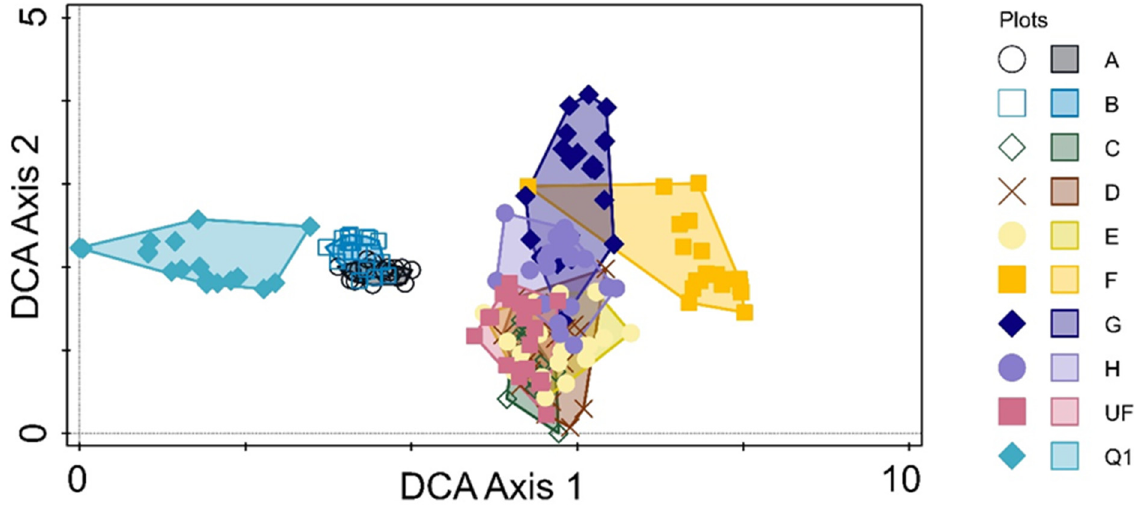
Figure 4. Detrended Correspondence Analysis (DCA) of 82 plant species (after down weighting of rare species) in 200 sample quadrates in 10 plots in a quarry abandoned 70 years ago (plots A–F on quarry floor, F–H on quarry top), in a recently decommissioned quarry (Q1) and an urban forest (UF). Separation of plots along the first and second axes indicated distinct understory vegetation communities at the quarry floor without tree canopy (plots A, B) and at the edge of the quarry top (plots F–H).